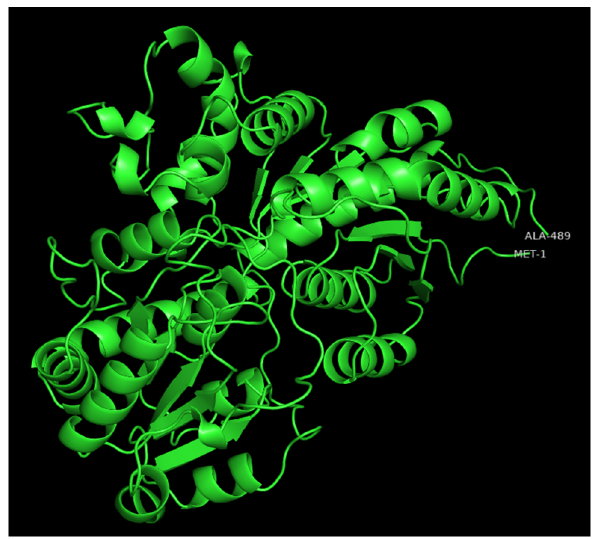
Figure 2. Modeled 3D structure of poplar UGT72A2 obtained with the intensive mode of the Phyre2 web portal [28] and visualized with PyMOL2. The first and last residues are indicated on the polypeptide chain.